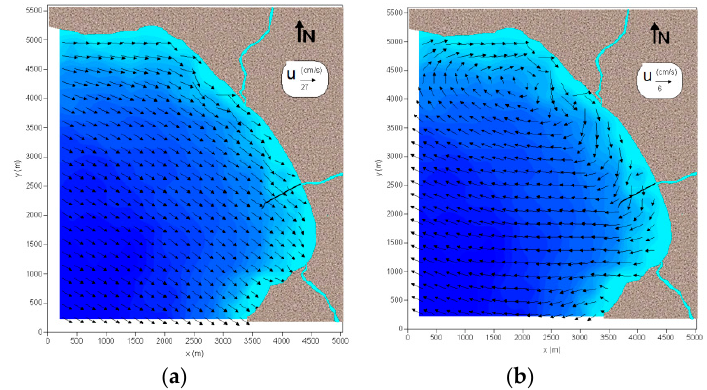
Figure 9. Current pattern: ( a ) sea surface layer and ( b ) bottom layer, for wind blowing from WNW with speed 10 m/s at the steady state [33].